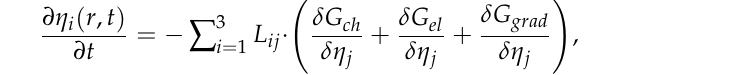
where G ch , G el , and G grad are the chemical Gibbs free, elastic, and interface energies, respectively, and L ij represents the kinetic coefficient, which is considered isotropic.